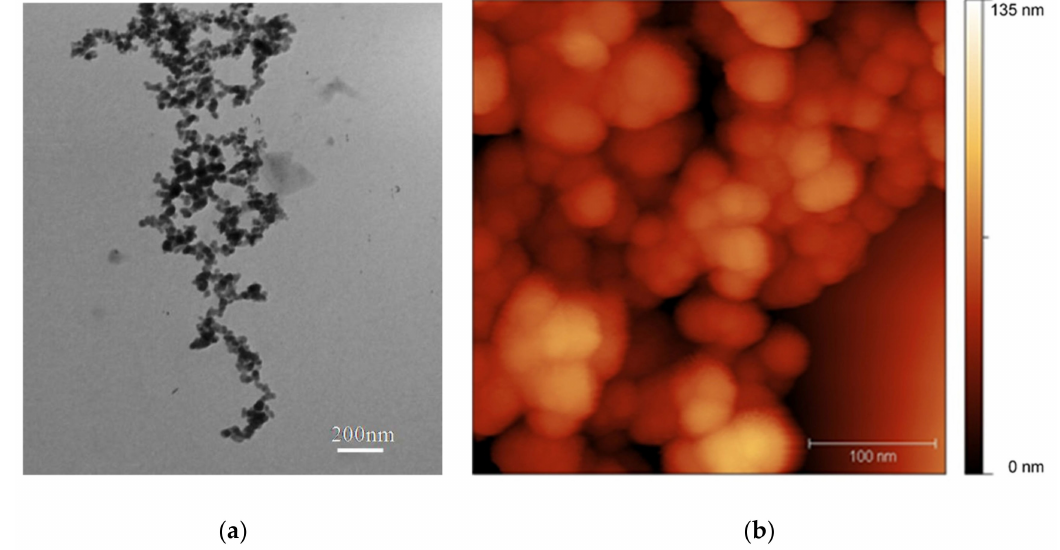
Figure 2. Representative images of SiO 2 particles obtained by transmission electron microscopy ( a ) and atomic force microscopy ( b ).